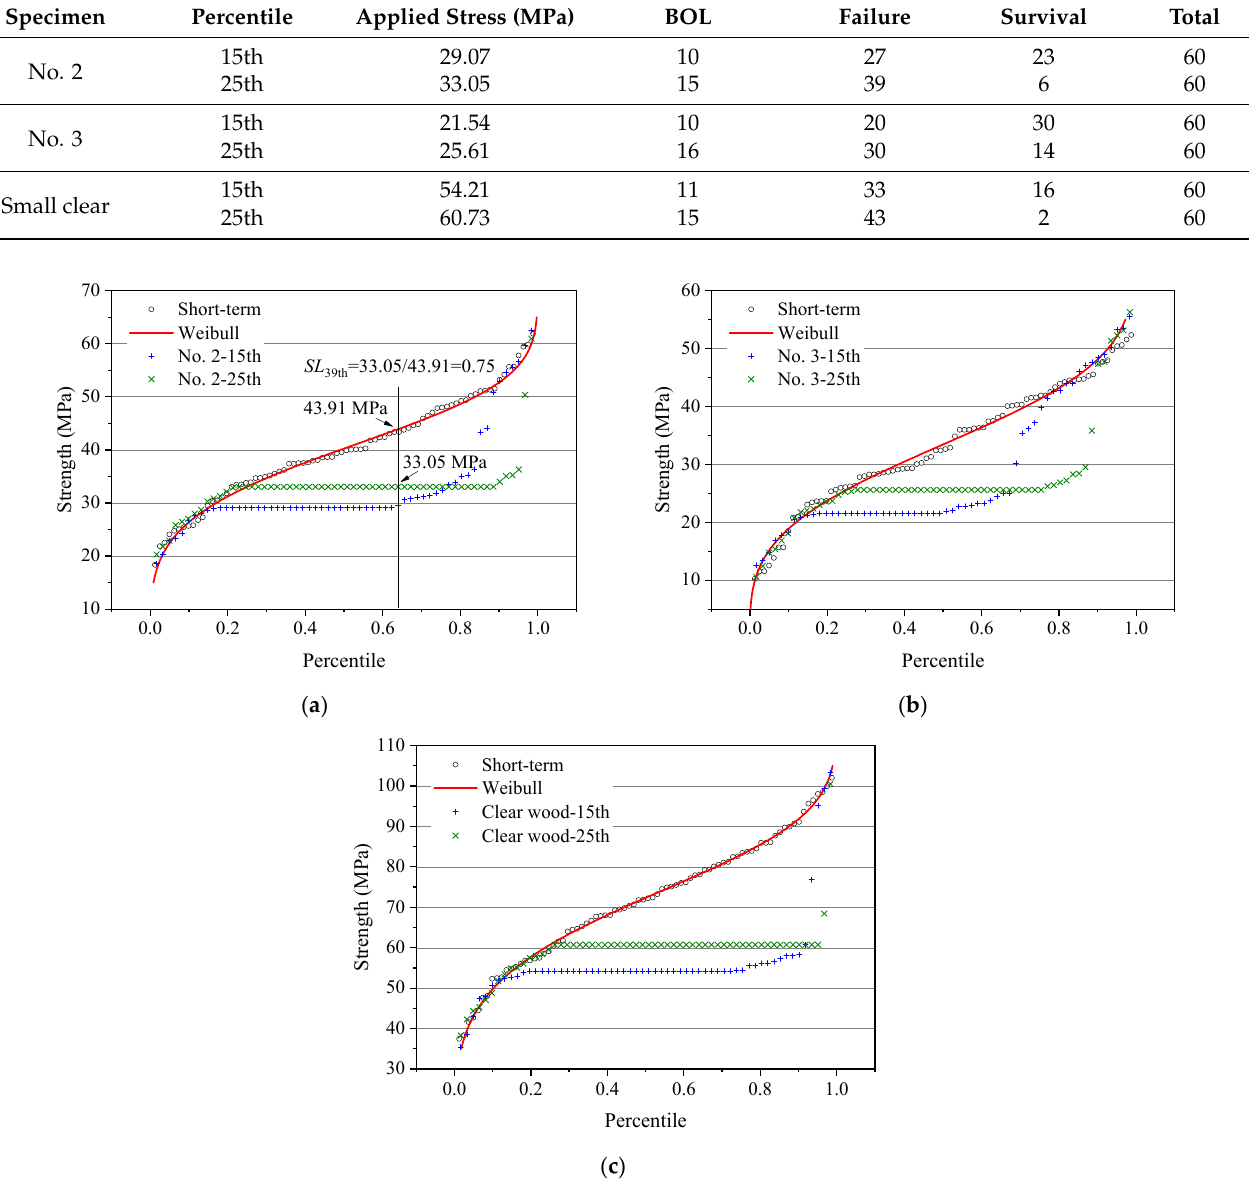
Table 4. Applied stress and specimen failure result in long-term tests.